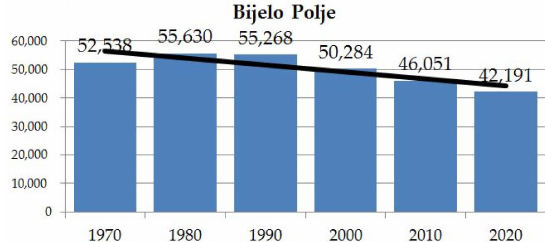
Figure 7. Demographic changes in the Bijelo Polje Region, Montenegro.